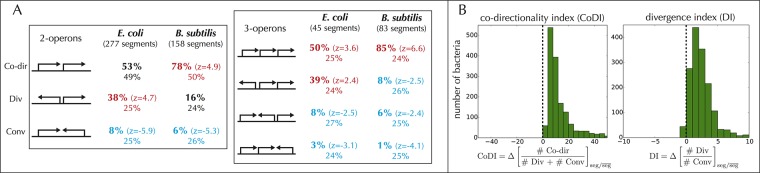
Relative orientations of operons inside synteny segments.A. Statistics in E. coli and B. subtilis over all synteny segments made of 2 and 3 operons exactly, showing that some organizations are over-represented (in red, with z > 1.65, i.e., p-value < 0.05) or under-represented (in blue, z < −1.65). Percentages on the first and second line correspond, respectively, to statistics within the segments and overall, for the total of 2647 operons in E. coli and 3450 operons in B. subtilis. B. The over-representation of co-directional genes or divergent operons inside the segments applies to every bacterial genome. This is demonstrated by computing, in each genome, indexes that reflect the statistics of gene orientations; the histograms indicate the distribution of these indexes over all genomes. For co-directionality, we define an index (CoDI) as the difference, between genes inside and outside segments, of the ratio of co-directional over divergent or convergent orientations, and observe that this index is positive in all genomes (left histogram). For divergence, we compute the difference of the ratio of divergent over convergent orientations (divergence index DI), a ratio that must be equal to 1 over an entire circular chromosome, and observe that DI is positive in almost every genome (right histogram).